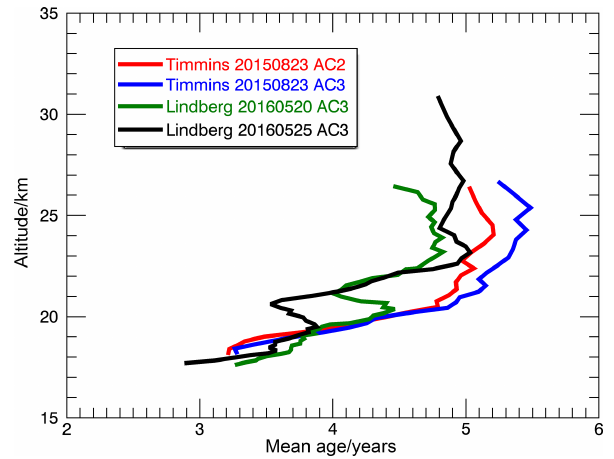
Figure 11. Vertical profiles of CO 2 derived mean age for the Air- Core observations by the University of Frankfurt in 2015 in Tim- mins, Canada and 2016 in Lindenberg, Germany.